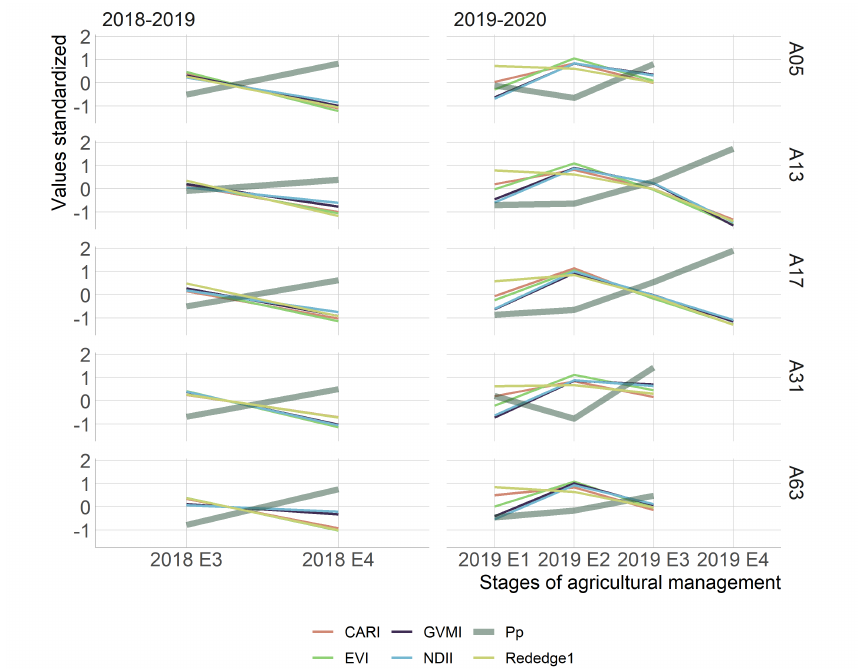
Figure 8. Temporal relationship between patch pressure (Pp) and vegetation indices. Average magnitudes per stage are